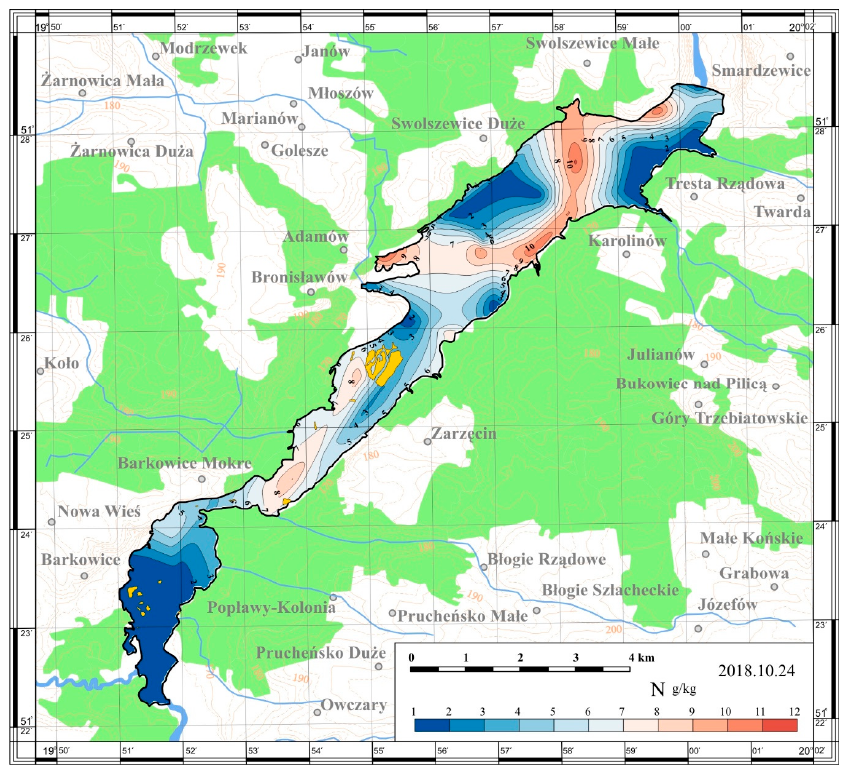
Figure 6. Spatial distribution of the total nitrogen content in the bottom sediments of the Sulejów Reservoir.